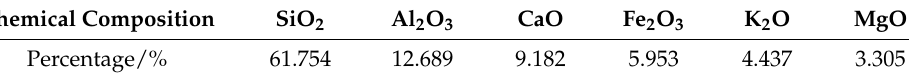
Table 1. Physical properties of classified fine tailings.